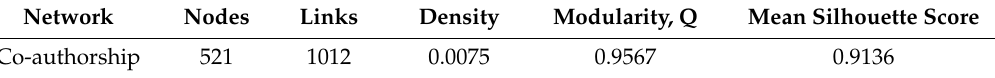
Table 4. List of the top 8 most productive authors (2010–2020).